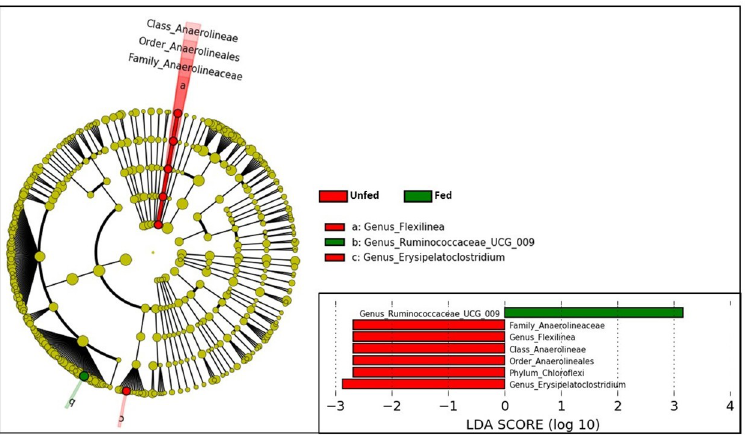
Fig 4. Differentially abundant microbial taxa between fed and unfed elk. Linear discriminate analysis was used to identify taxa (phylum-genus levels) that exhibited log-two-fold abundance changes between the two groups.